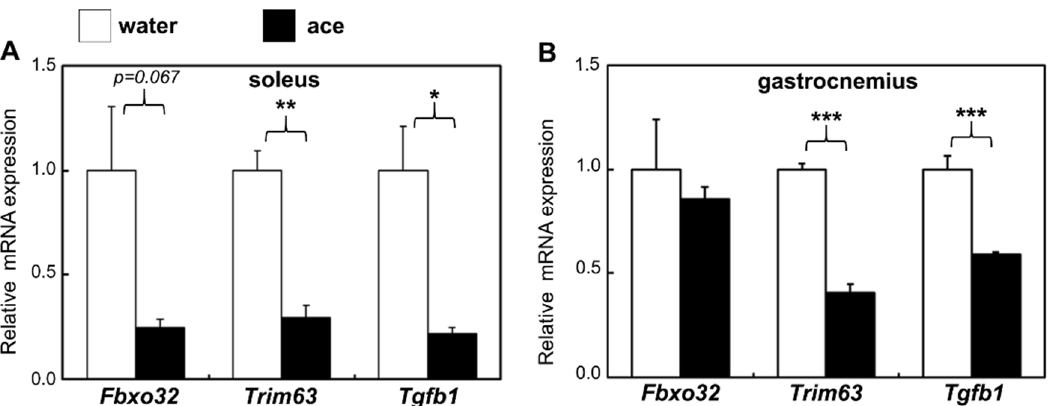
Figure 3. Effect of long-term supplementation with acetic acid on the relative mRNA expression of Fbxo32, Trim63, and Tgfb1 genes in the soleus ( A ) and gastrocnemius ( B ) muscles of SD rats at 56 weeks of age in the water ( □ ) and acetic acid (ace, ■ ) groups. Values represent means ± SE for 4 – 5 rats. * p < 0.05, ** p < 0.01, *** p < 0.001, statistically significant versus the value of water group. Results were analyzed with Student’s t -test.